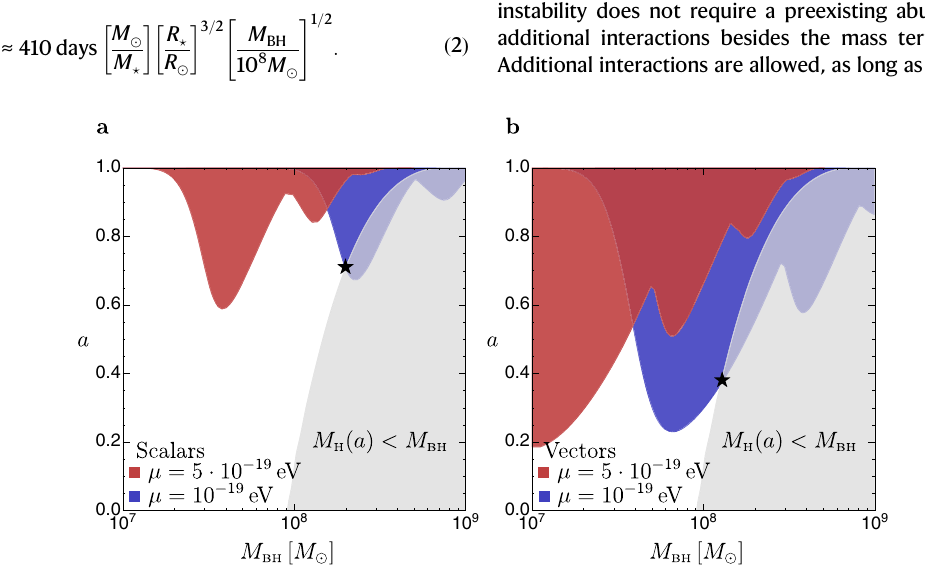
Fig. 1 | Hillsmassand superradiant spin-downduetoscalarsand vectors. Gray: region in the plane of the SMBH mass M BH and spin a , where the SMBH mass exceeds the Hills mass for a Sun-like star. In this region, no observable TDEs occur for such type of stars. The spin dependence of the Hills mass is taken from ref. 4.